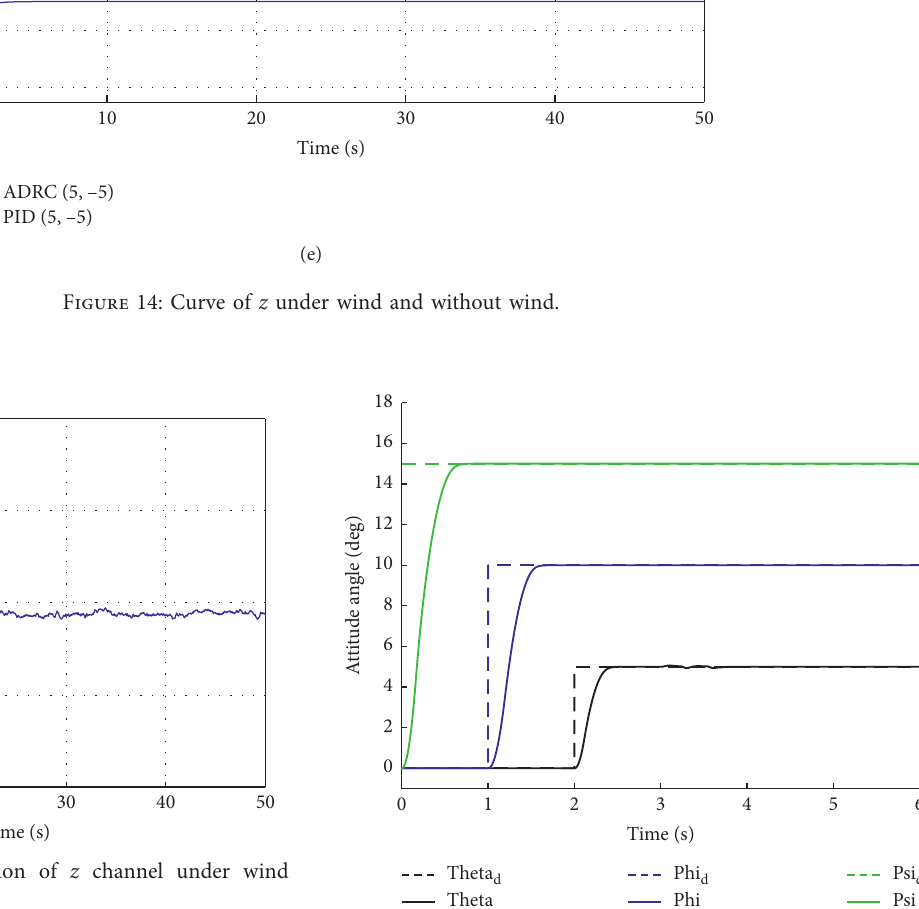
Figure 16: Tracking control with pruning